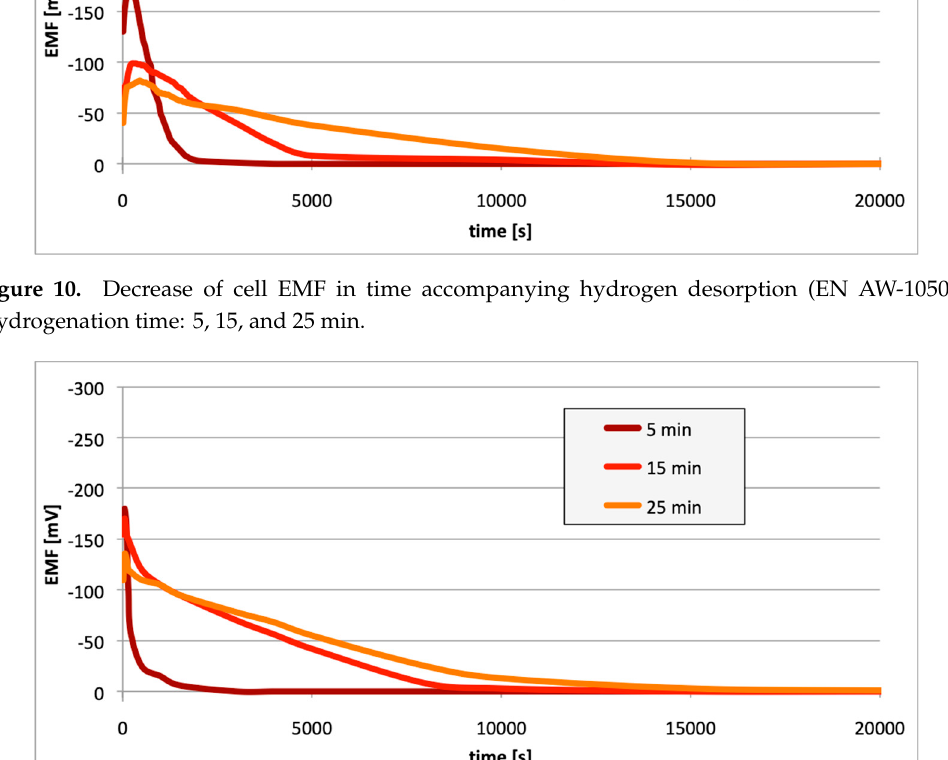
Figure 11. Decrease of cell EMF in time accompanying hydrogen desorption (EN AW-5754). Hydrogenation time: 5, 15, and 25 min.